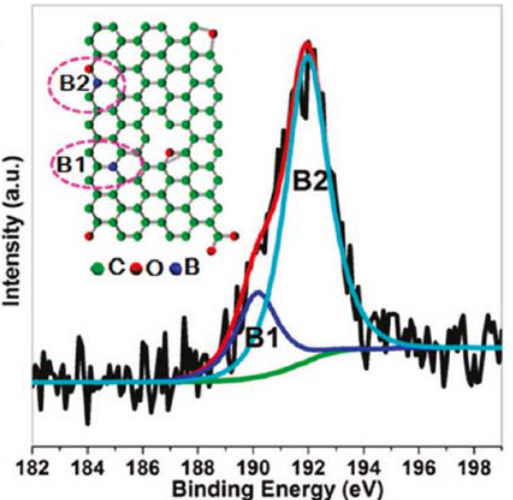
Figure 4. Synthesis of B-GNS using the thermal annealing method. Adapted from Yeom et al. [94], with permission from Springer. Copyright (2015).